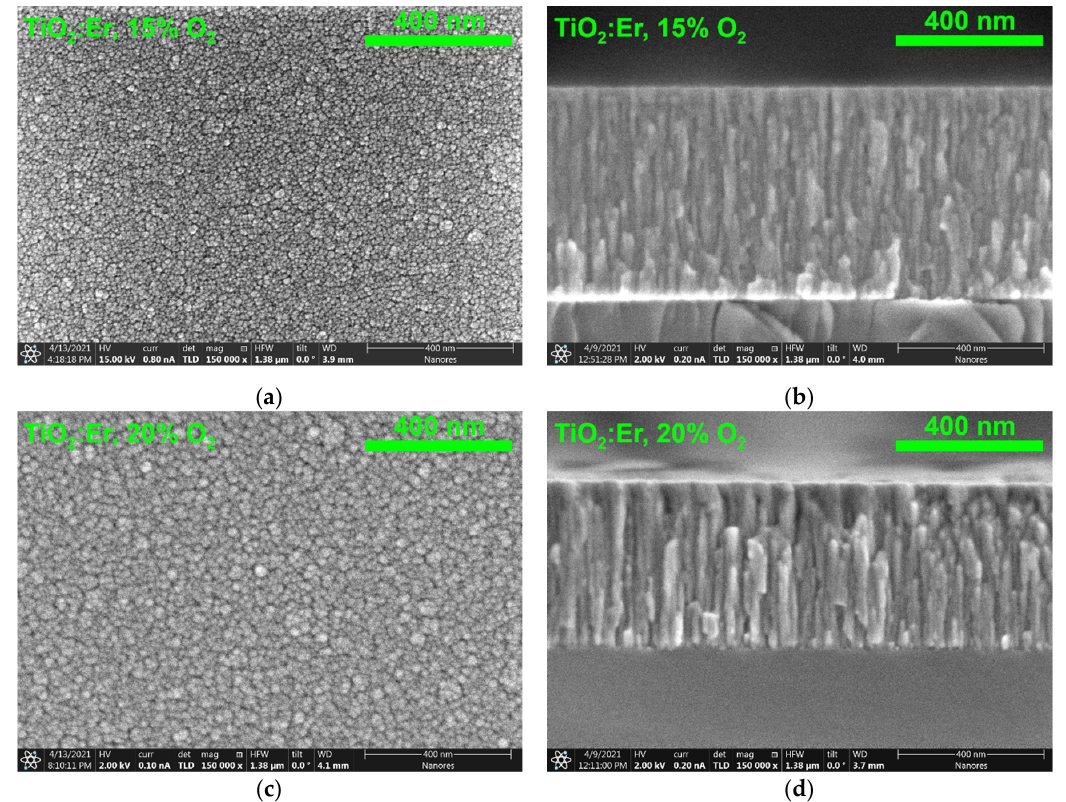
Figure 3. SEM images of the surface and cross-section of TiO 2 :Er thin films deposited at ( a , b ) 15% O 2 and ( c , d ) 20% O 2 .